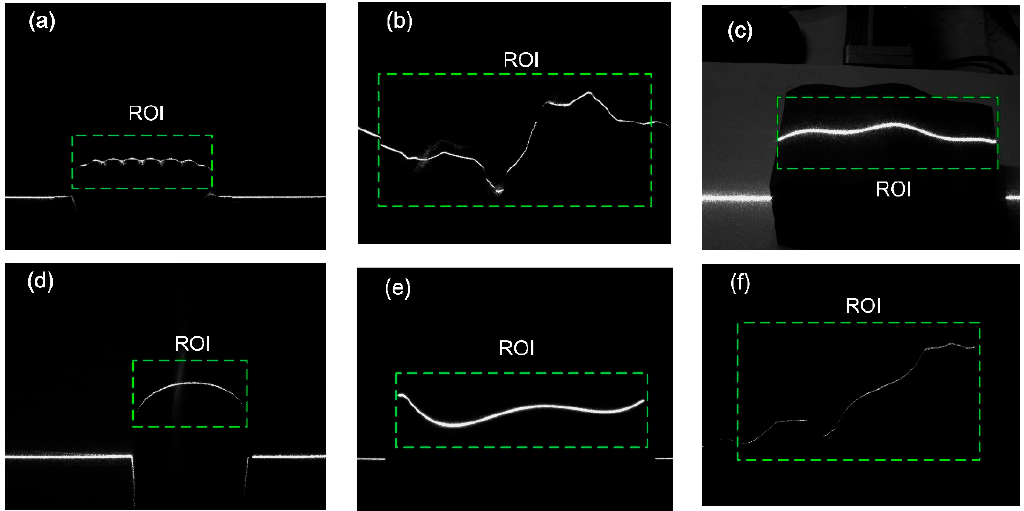
Figure 9. Stripes for network training and verification. ( a ) Normal exposed wave stripe; ( b , f ) under exposed random stripes; ( c , e ) over exposed smooth stripes; ( d ) normal exposed arc stripe.